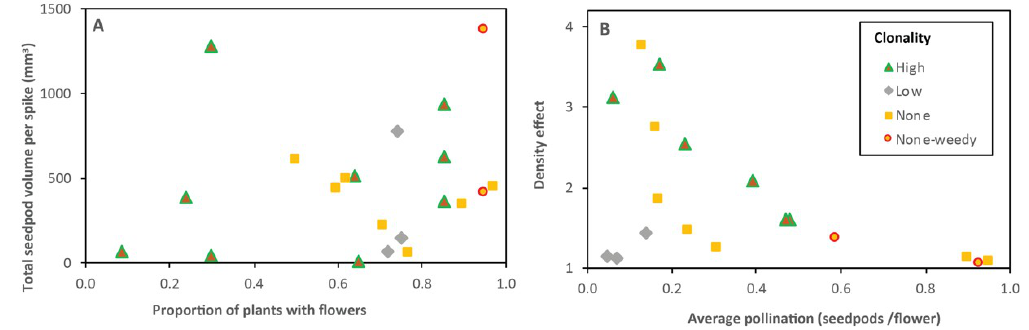
Figure 12. Graphs showing links between clonality and seed production for 22 orchid species (one point each); ( A ) Seed output relative to the proportion of plants with flowers; ( B ) The impact of plant density on fruit set (small group average / mean) relative to the average rate relative to clonality (see 11D for comparison).